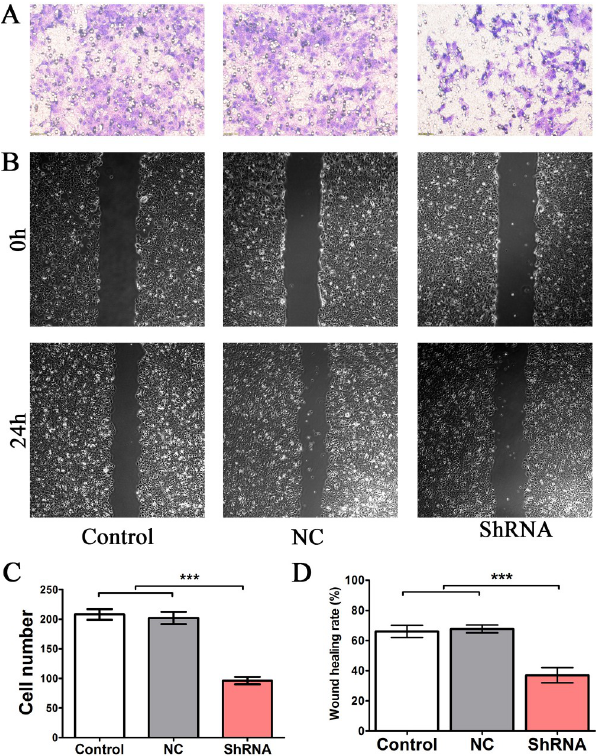
Fig 5. Effects of LINC00922 knockdown on HCG27 cell invasion. (A) Representative images of the Transwell assay of control cells and those transfected with shRNAs and NC. (B) Representative images of the wound-healing assay showing that cell migration was inhibited in cells transfected with shRNAs. (C) Quantification of Transwell assays in control cells and those transfected with shRNAs and NC. (D) Quantification of wound-healing assays in control cells and those transfected with shRNAs and NC. ��� P <